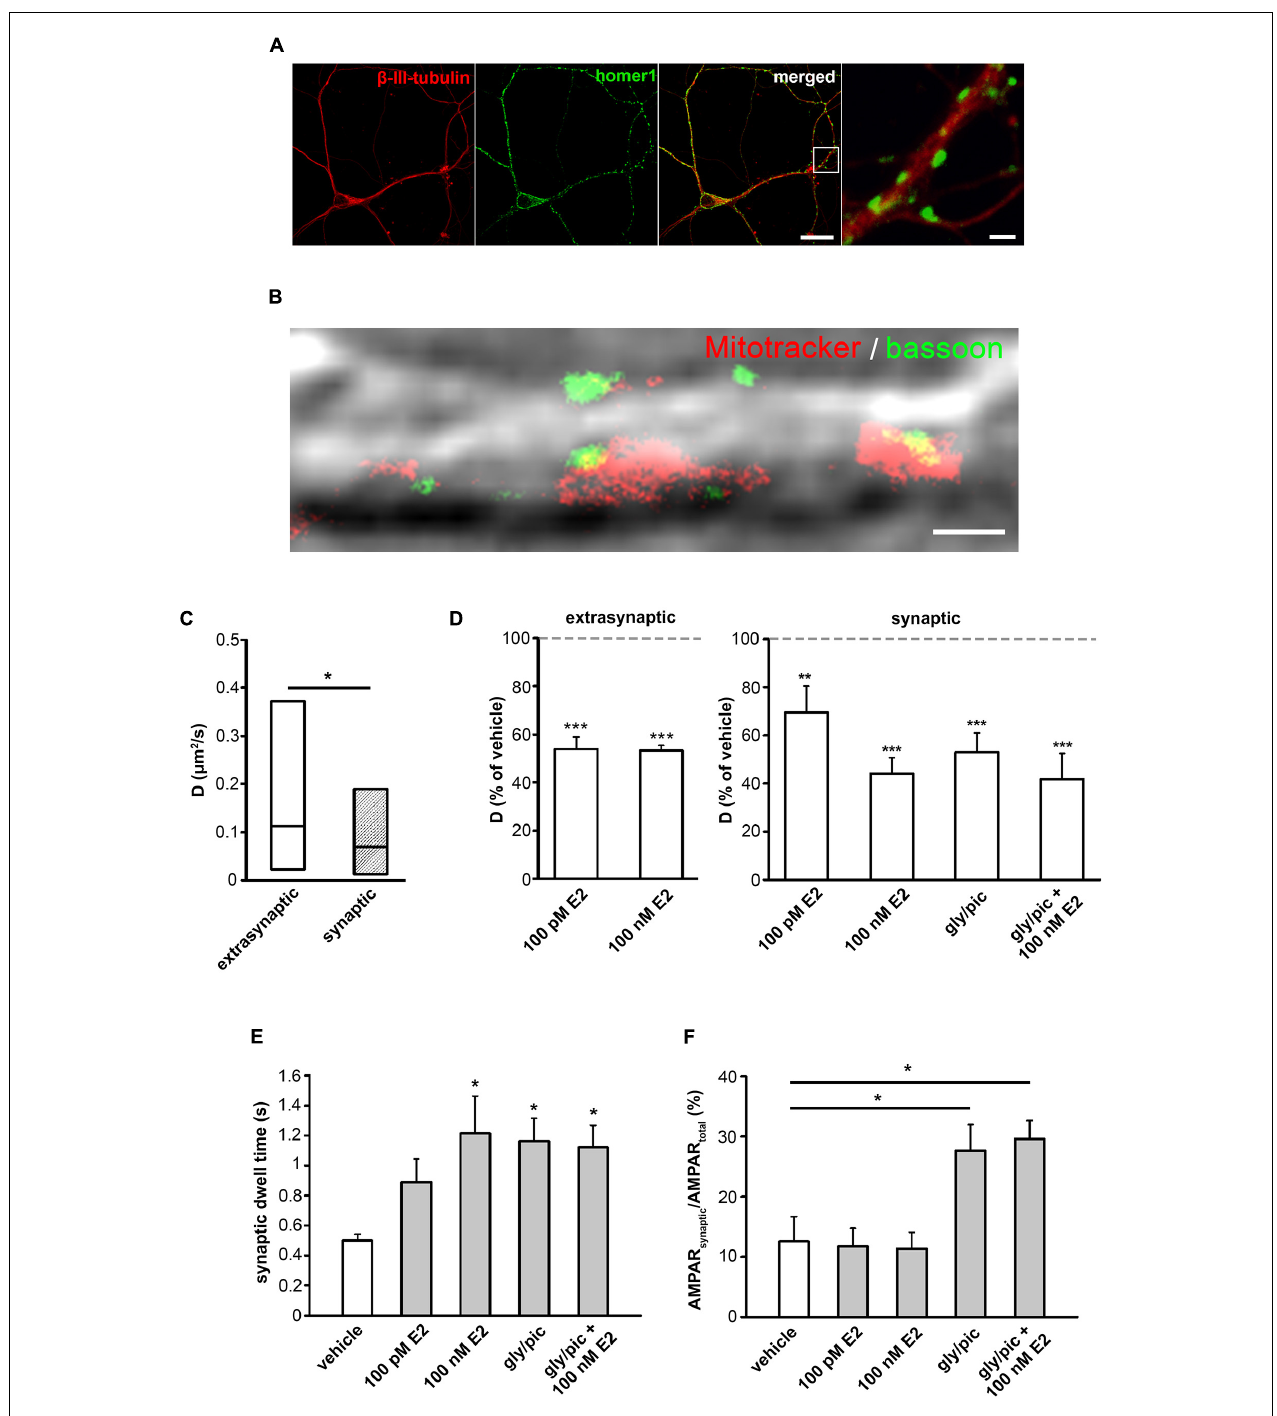
FIGURE 6 | Effect of E2 on the surface movement of GluR2-AMPA on primary hippocampal neurons. (A) Photomicrograph shows a primary hippocampal neuron labeled with homer-1 (synapse) and β -III tubulin (neuron). Scale bar = 10 µ m, insert Scale bar = 2 µ m. (B) Dual color STED image of a hippocampal neuron overlayed to differential interference contrast microscopy image depicts live-cell synapse labeling MitoTracker Deep Red (red) and presynaptic protein bassoon (green). Scale bar = 1 µ m. (C) Distribution of D values of extrasynaptic and synaptic GluR2-AMPAR under control conditions (median ± IQR, n = 754 extrasynaptic trajectories and n = 104 synaptic trajectories). (D) Effect of E2 (100 pM and 100 nM) on D of extrasynaptic and synaptic GluR2-AMPA with or without chemical LTP (cLTP) induced by glycine/picrotoxin (gly/pic) (% of vehicle treatment as the mean ± SEM; n = 742–928 extrasynaptic trajectories and n = 104–155 synaptic trajectories). (E,F) Effect of vehicle, E2 (100 n, 100 pM) with or without cLTP (gly/pic) on synaptic dwell time (mean ± SEM (s); n = 104–155) (E) and relative surface distribution of synaptic GluR2-AMPAR content (synaptic/total GluR2-AMPA molecule trajectories) (mean ± SEM, n = 8–18 recordings) (F) . * p < 0.05; ** p < 0.01; *** p < 0.001.